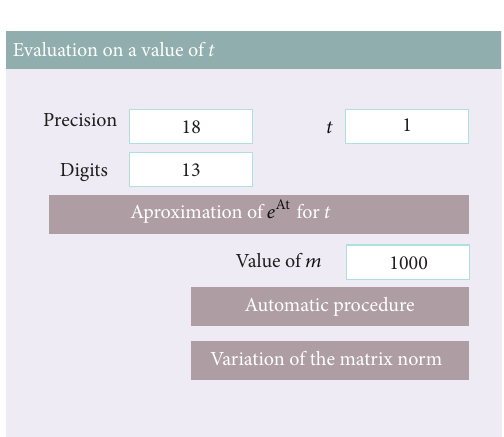
Figure 8: Parameters related to the accuracy of the solution to the differential equation.